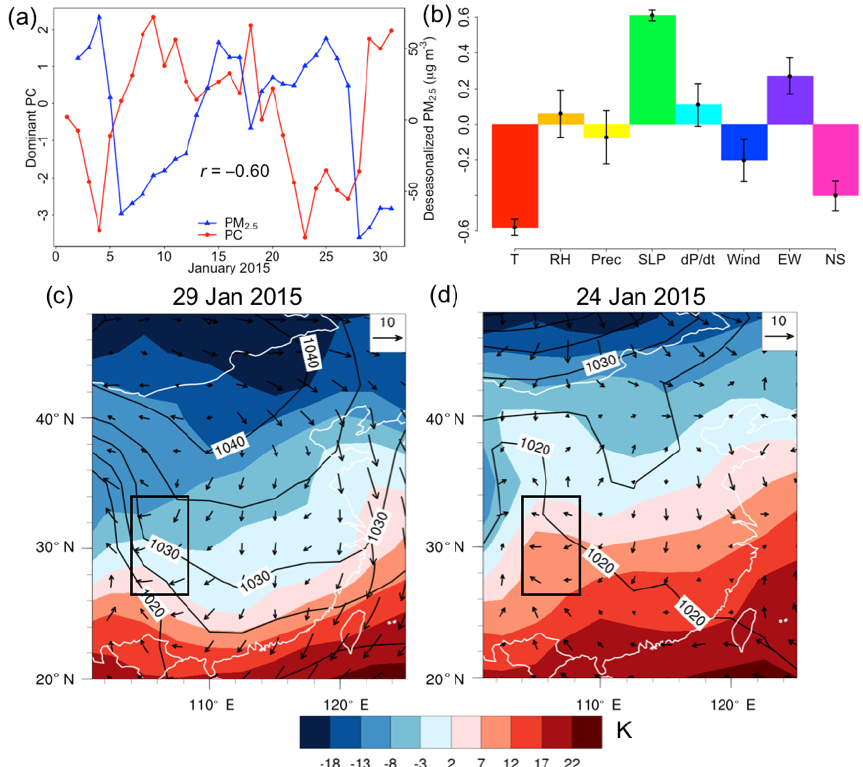
Figure 6. Same as Fig. 3 but for winter in the Sichuan Basin (SCB). (a) Deseasonalized total PM 2 . 5 concentrations and the PC time series in the sample month of January 2015. (b) Composition of this dominant mode as measured by the coefficients α kj . (c–d) Synoptic weather maps on 29 and 24 January 2015. Panel (c) shows the positive influence characterized by a cold front from the Siberian High that advects PM 2 . 5 away, while panel (d) shows the negative influence characterized by stagnation over SCB. Temperature (K) is shown as shaded colors, wind speed (ms − 1 ) as vectors, and sea level pressure (hPa) as contours. The rectangles indicate